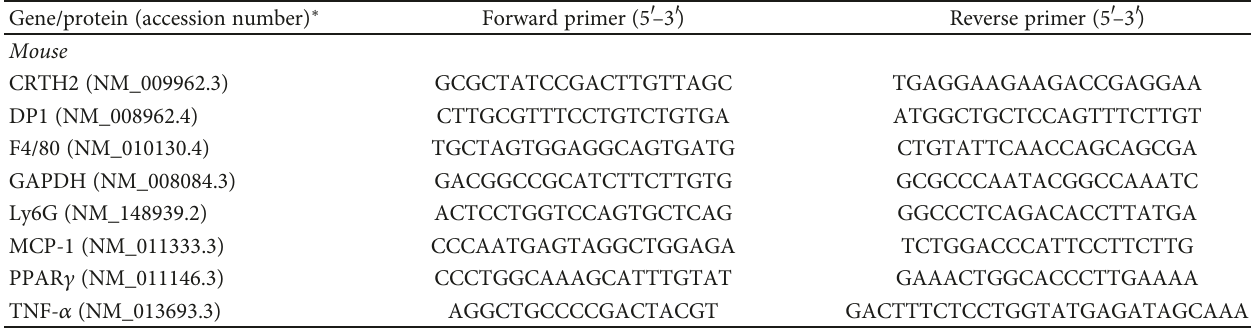
Table 1: Primers used for qPCR ampli fi